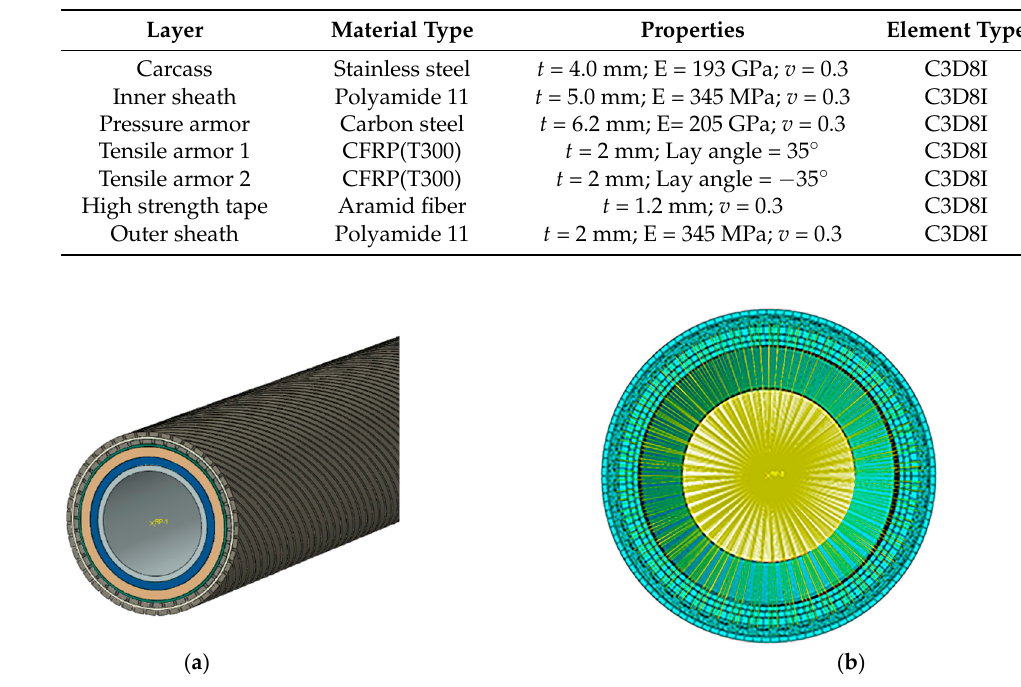
Table 5. Characteristics of the analyzed 4-inch (101.6 mm) flexible pipe.